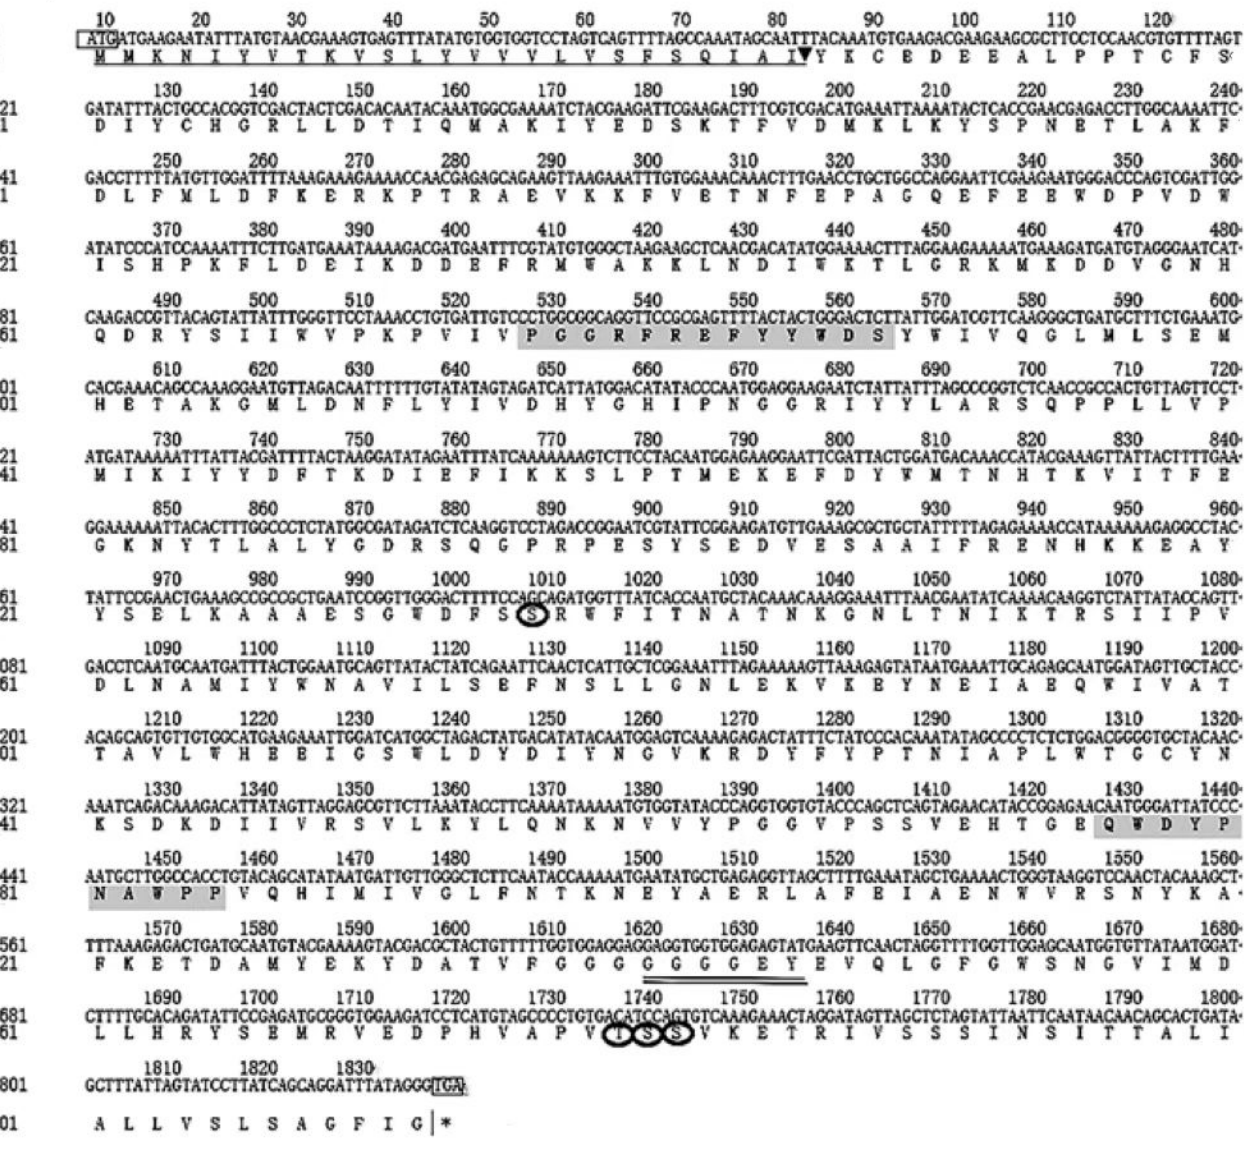
Figure 1. Nucleotide sequence and deduced amino acid sequence of LoTRE1 . The black box in the figure indicates the start codon (ATG) and stop codon (TGA). Underlined amino acid residues (1–25) and the arrowhead represent the signal peptide and putative cleavage site, respectively. Trehalase signature motifs (amino acid residues 176–189 and 476–485) are shaded. Four potential N-glycosylation sites (amino acid residues 336, 579, 580, and 581) are encircled. The highly conserved glycine-rich region is double underlined.